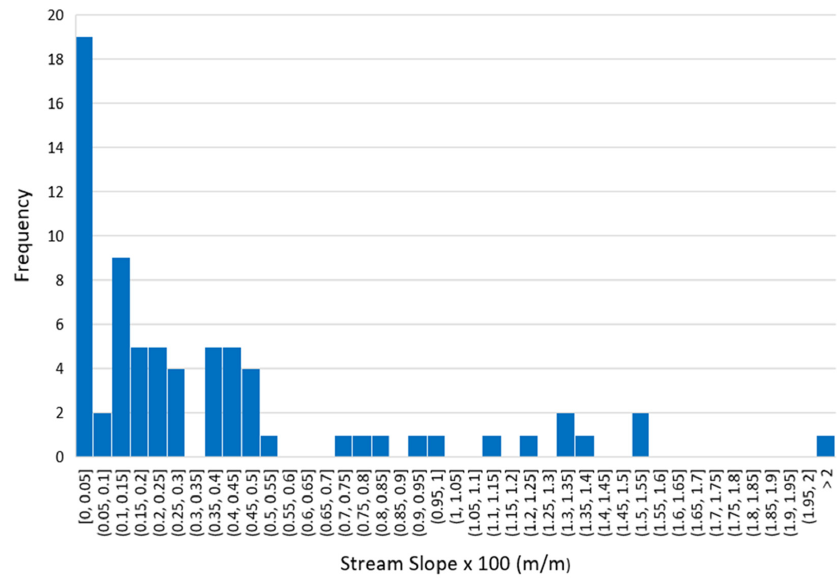
Figure 7. Stream slope at low head dams in sample states with fatalities recorded.